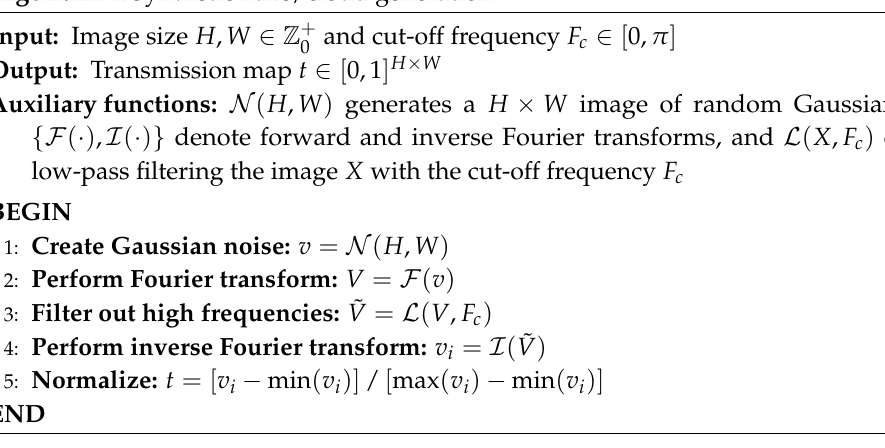
Algorithm 2 Synthetic haze/cloud generation